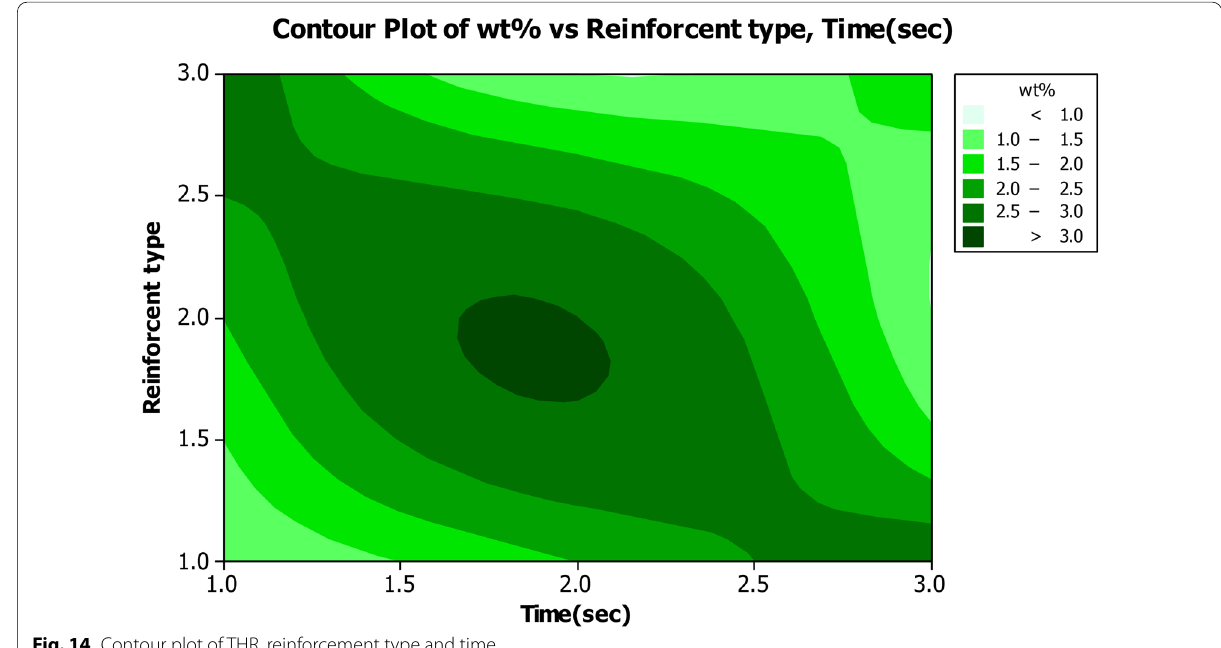
Fig. 14 Contour plot of THR, reinforcement type and time